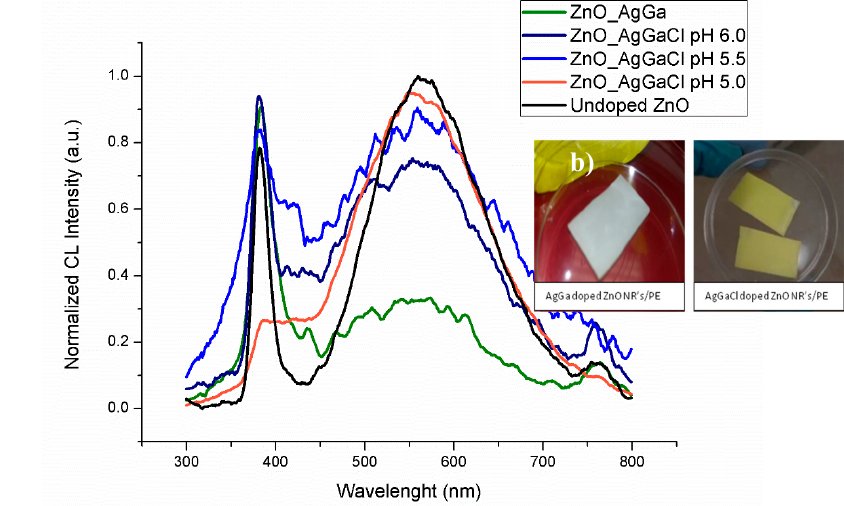
Figure 4. ( a ) Cathodolumniscence spectra of undoped ZnO NRs, AgGa-doped ZnO NRs and AgGaCl-doped ZnO NRs ( b ) AgGa-doped ZnO NRs and AgGaCl-doped ZnO NRs on PE substrate samples.